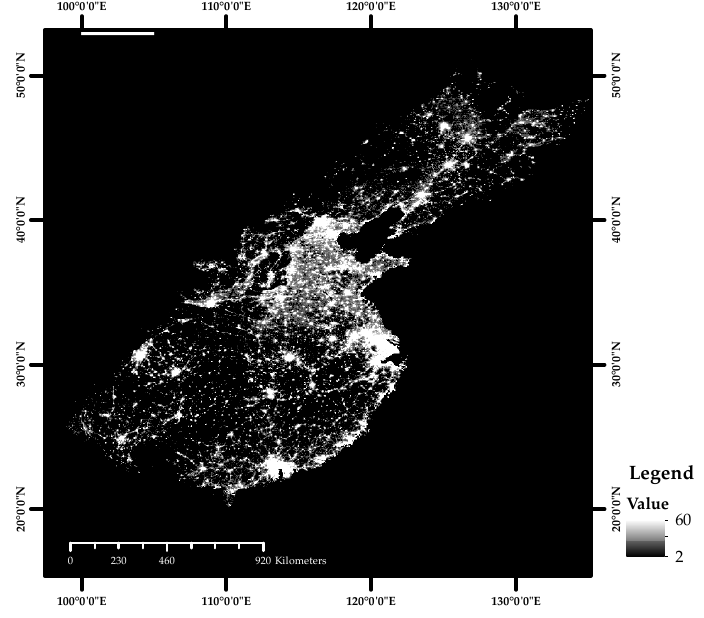
Figure 5. Preprocessed DMSP/OLS Data.